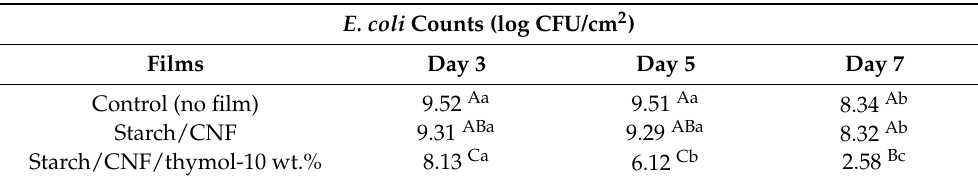
Table 2. Antibacterial activity of control, starch/CNF bionanocomposite film, and starch/CNF/thymol bionanocomposite film against E. coli on fresh meat